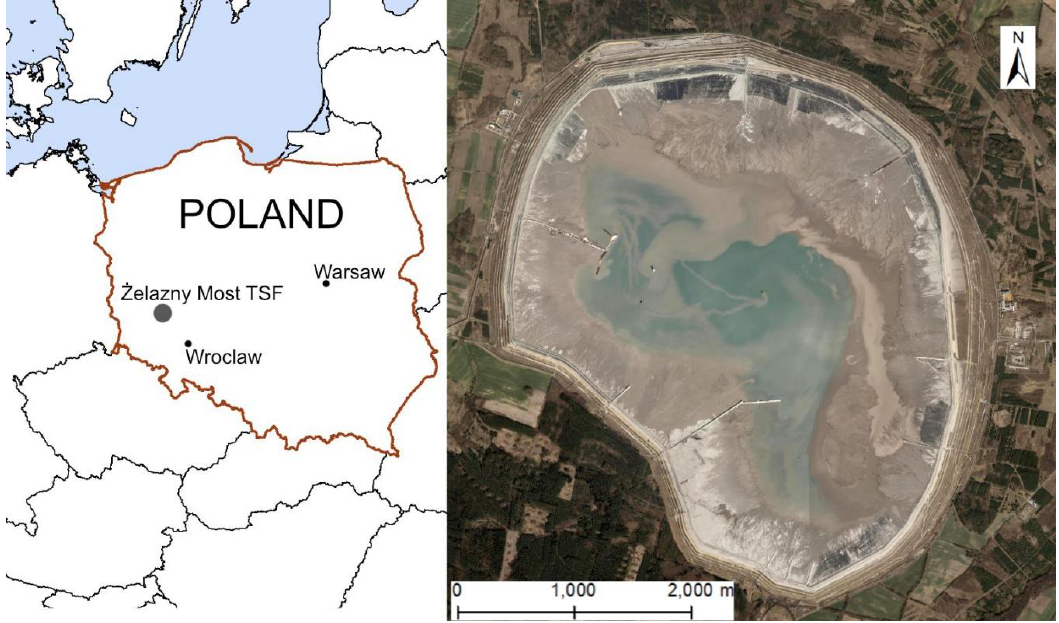
Figure 1. Location and aerial view of the Żelazny Most Tailings Storage Facility (TSF).